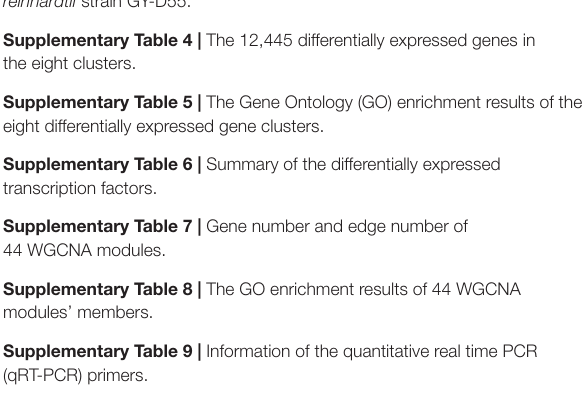
clusters were shown separately. A red color indicates that the gene is highly expressed under the corresponding treatment. Supplementary Table 1 | The t -test analysis result of the growth ratio between cells under control and saline condition. Supplementary Table 2 | Summary of mapping transcriptome reads to the reference sequence.